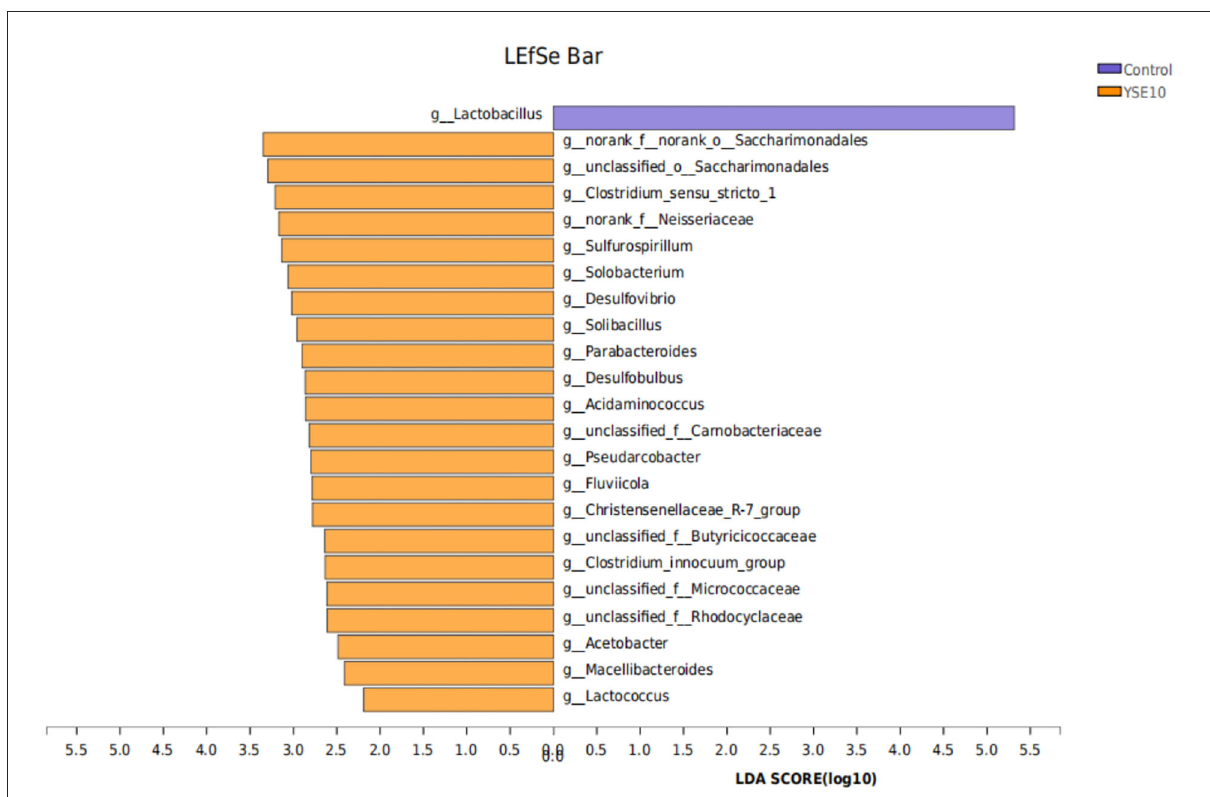
FIGURE5 LDA Effect Size (LEfSe) algorithm was used on genus-level OTU tables to determine taxa that best characterize each biological class. Control, 0.9% NaCl solution; YSE10, 10 mg/mL YSE. LDA, linear discriminant analysis.